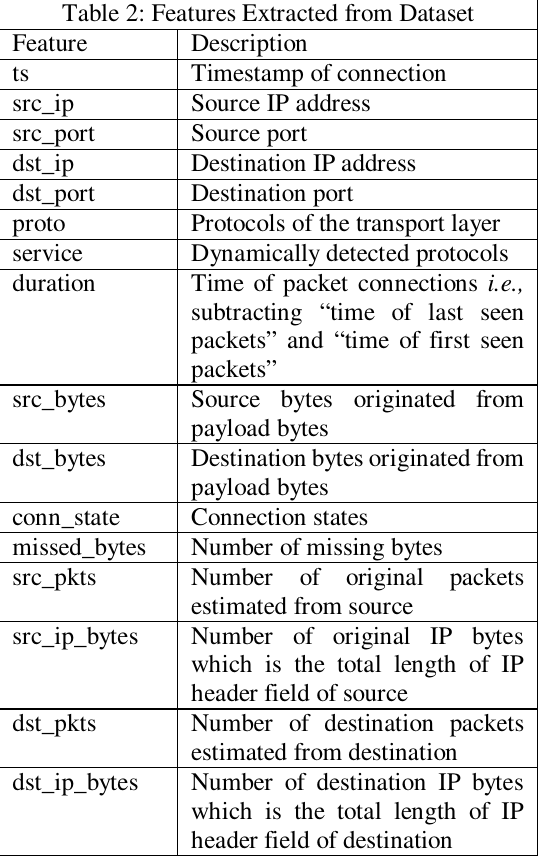
Table 2: Features Extracted from Dataset